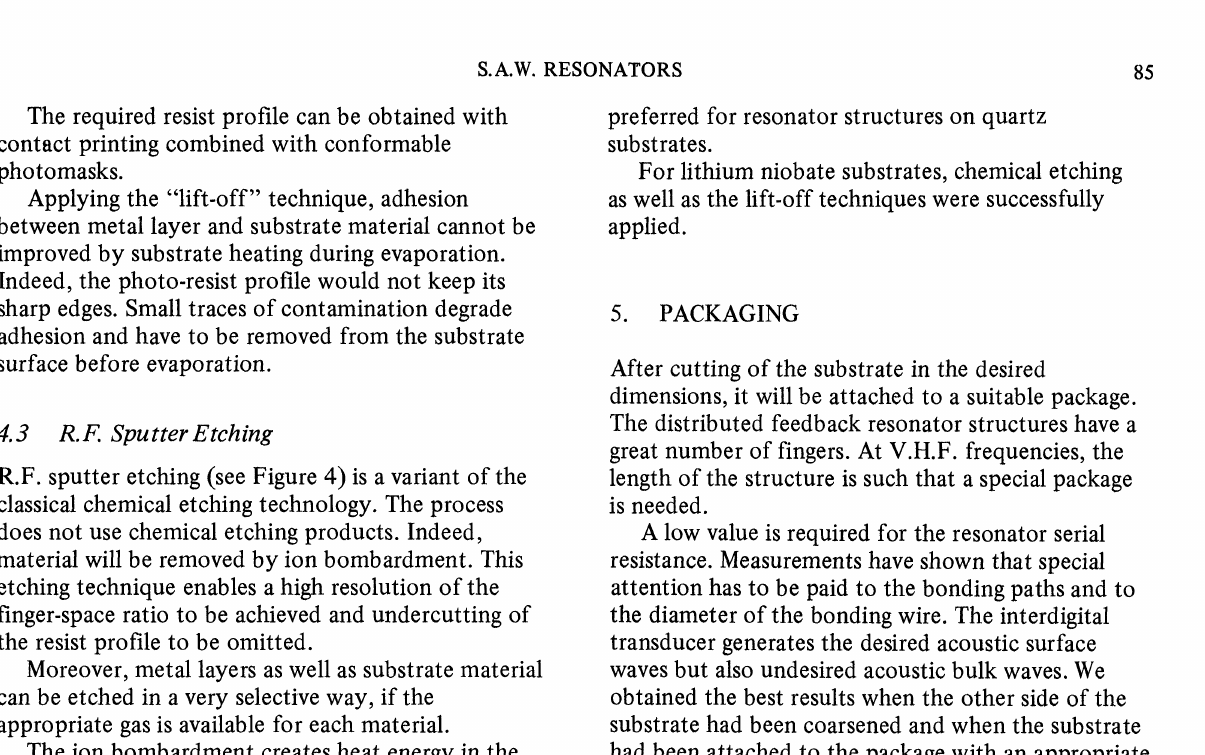
I\\\\ metal Igyer substrate RF sputter etching technique FIGURE 4 after the development step of the resist after sputter